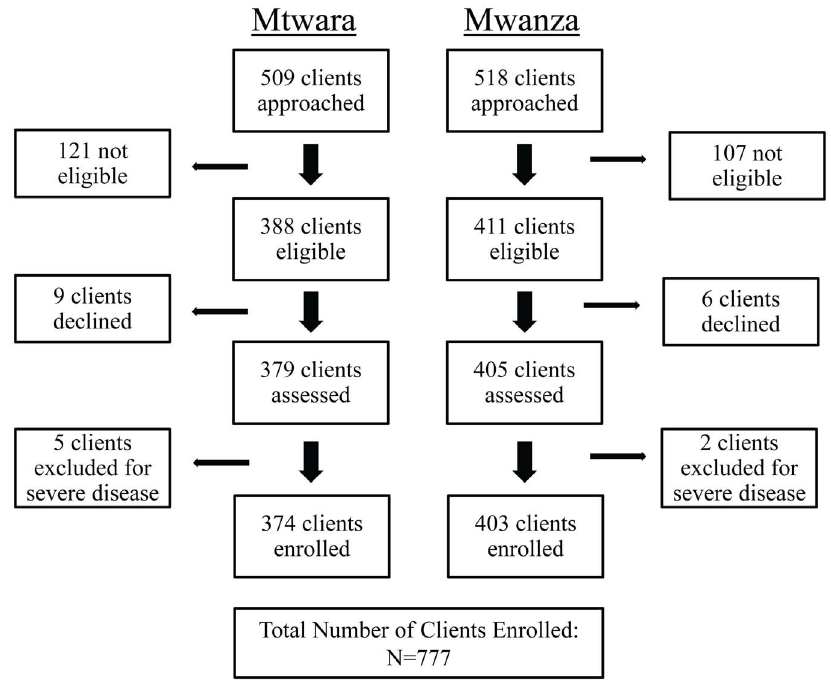
Figure 2. Client Recruitment.